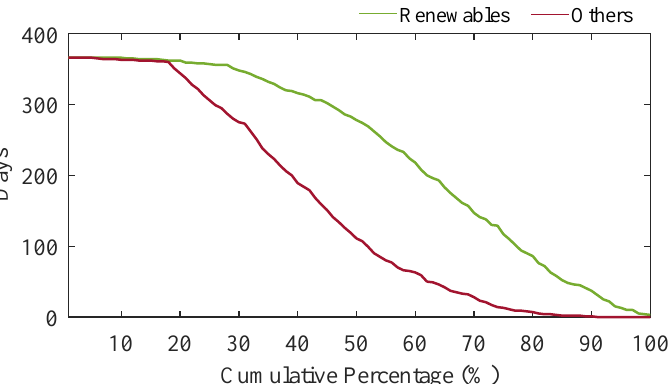
Figure 5. Cumulative renewable energy generation participation in South Australia during December 2020 to December 2021 (plot drawn with data from